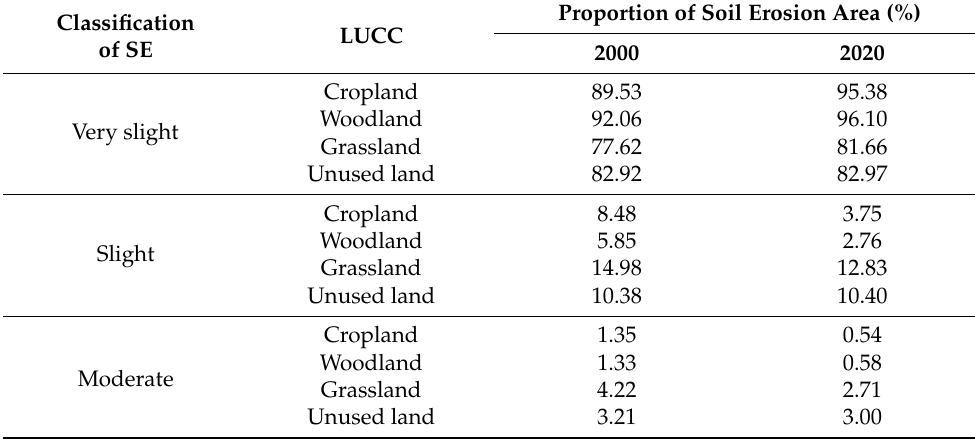
Table 6. Proportion of different land-use areas under different soil erosion grades in the YRB